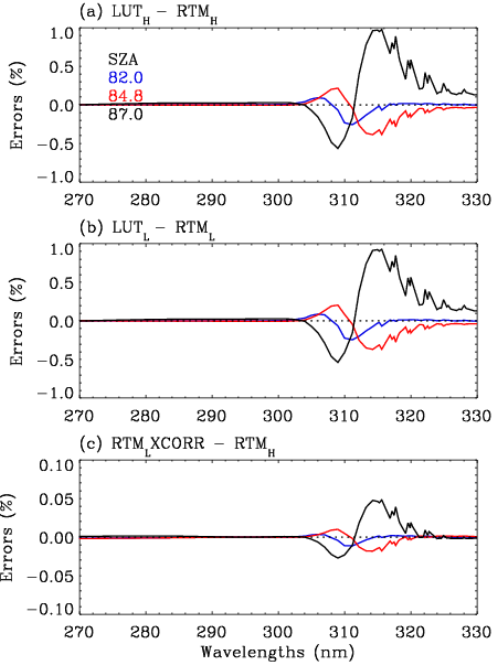
Figure 7. Comparisons of radiance simulations at VZA = 61 ◦ and AZA = 0 ◦ for extreme SZAs. LUT and RT model represent LUT- and online RT-based calculations, respectively, with the sub- scripts H and L indicating high- and low-accuracy configurations, whereas CORR represents the correction spectrum taken from LUT H / LUT L .